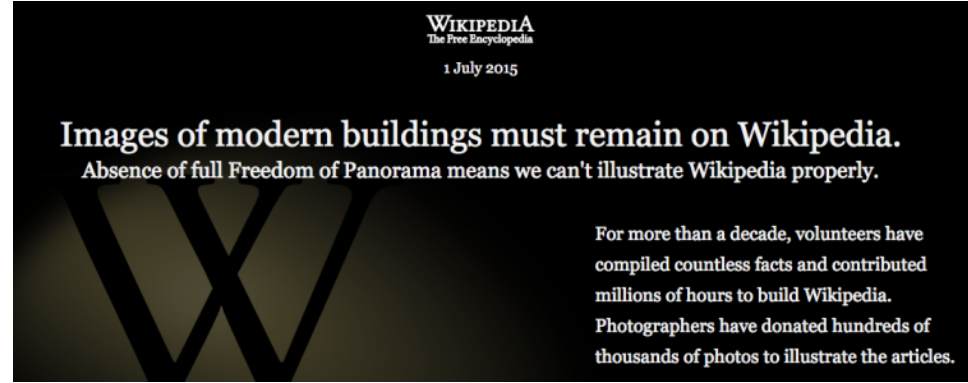
Figure 2: The banner displayed on the English Wikipedia in July 2015